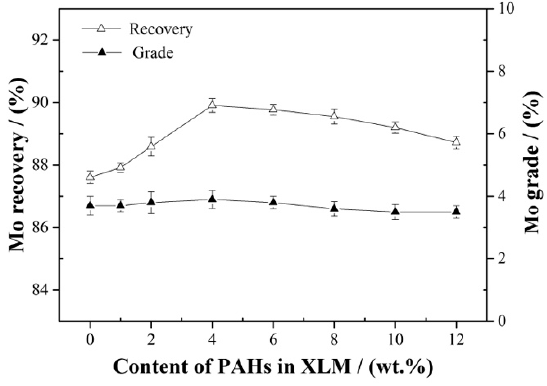
Figure 4. Influence of the content of PAHs in XLM on molybdenite flotation in HCFW (800 mg/L Ca 2+ , pH = 8–9).